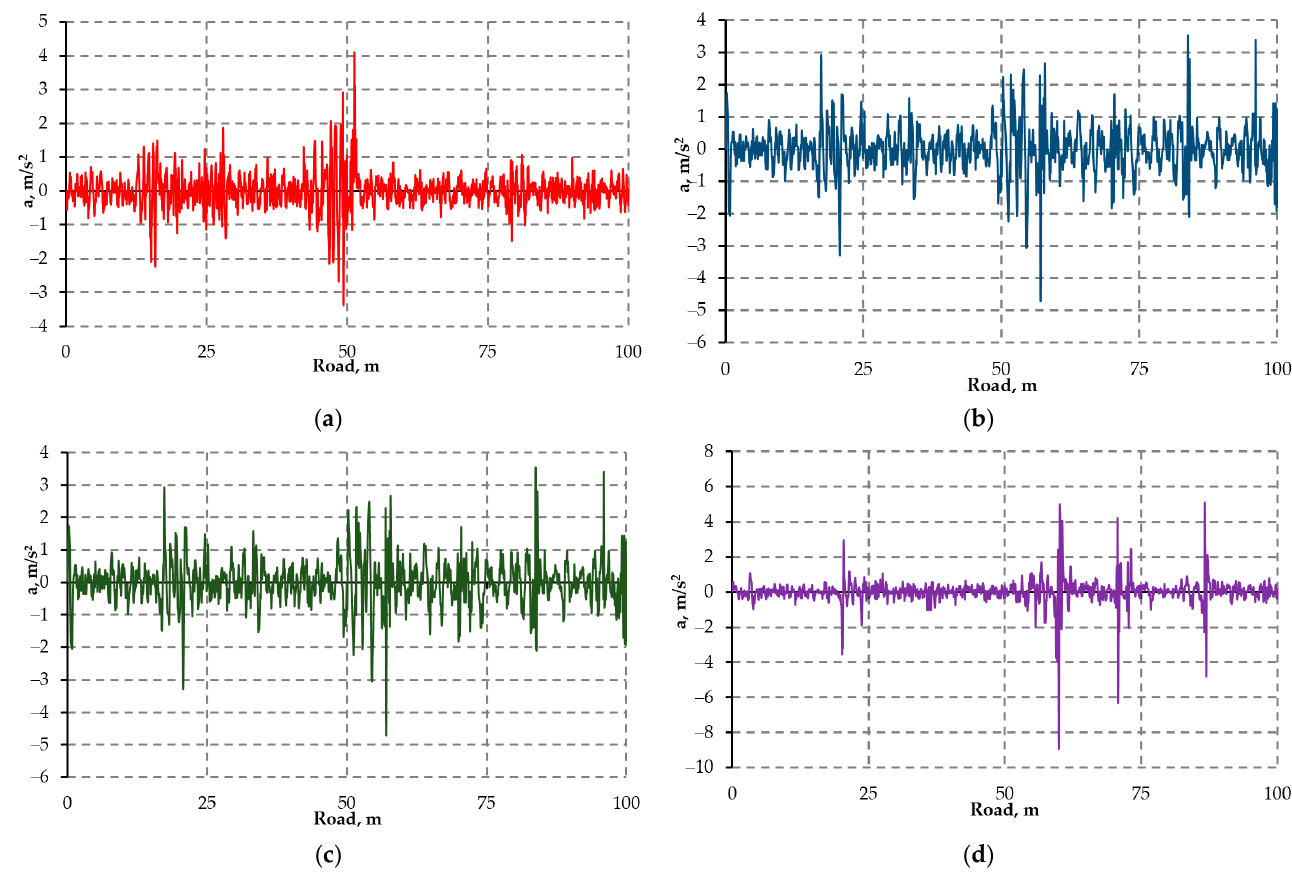
Figure 25. Accelerations of the sprung masses of compact car measured on a city-type road at different speeds: ( a , b )-front; ( c , d )-rear; ( a , c )-50 km/h; and ( b , d )-70 km/h.